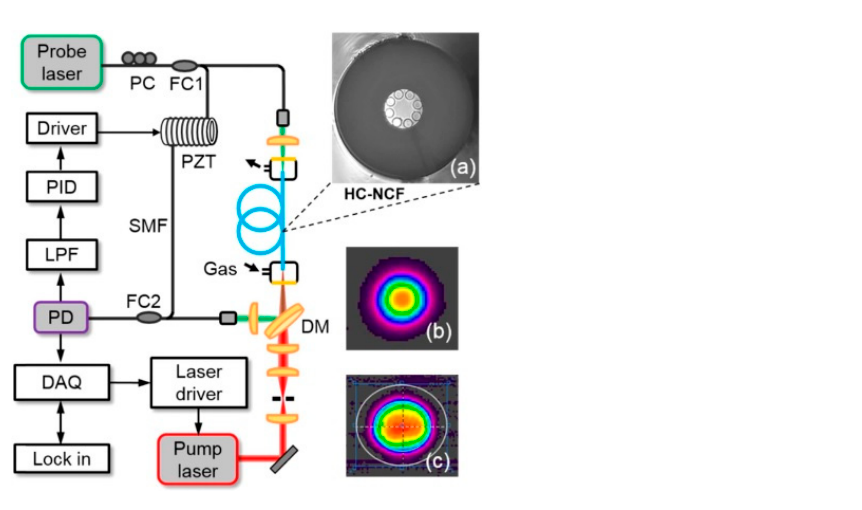
Figure 8. Schematic diagram of the MZI PTS sensor utilizing an HC-NCF as an absorption cell used to detect CO at 2327 nm. The fiber was filled with the gas analyte using gas filling cells placed at both ends. HC-NCF—hollow core negative curvature fiber (ARHCF), PID—proportional-integral- derivative controller, PD—photodetector, LP—Flow-pass filter, FCfiber coupler, PCpolarization controller, PZT—piezo-electric transducer, DM—dichroic mirror. ( a ) Cross-section of the HC-NCF used in the experiment. ( b ) HC-NCF-delivered beam profile. ( c ) Profile of the beam emitted by the pump laser. Reprinted with permission from [50] © The Optical Society.